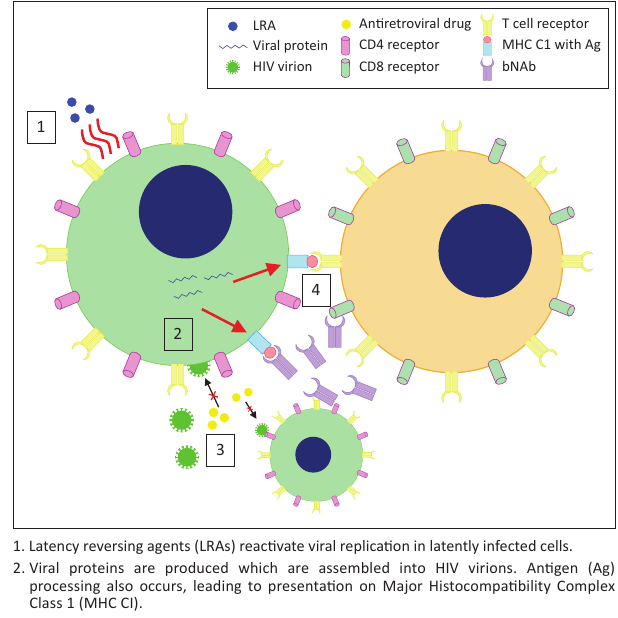
FIGURE 1: Proposed mechanism of ‘Shock and